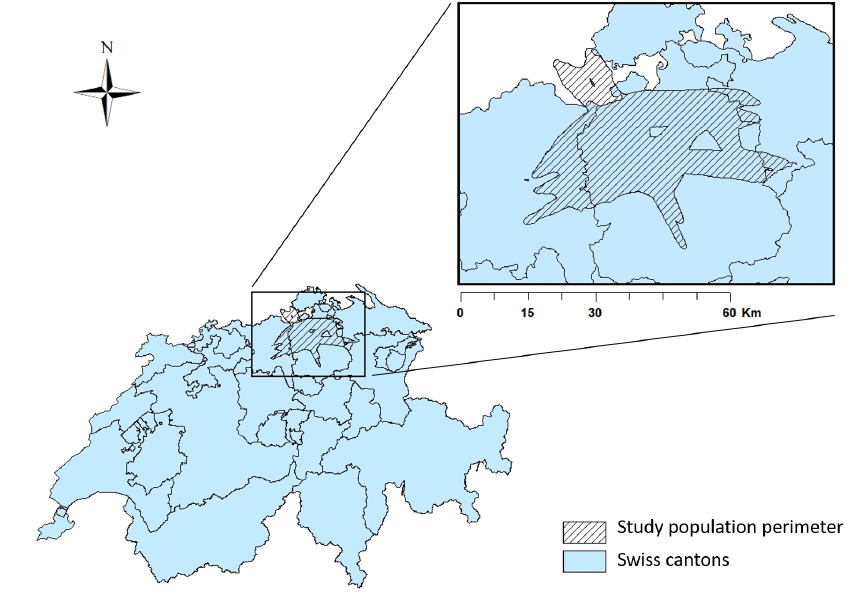
Figure 3. Overview of the study area used to select the study population around